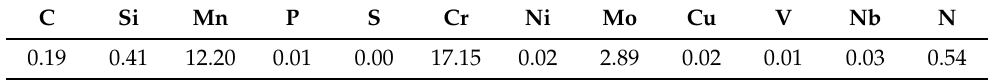
Table 1. Chemical composition of P558.